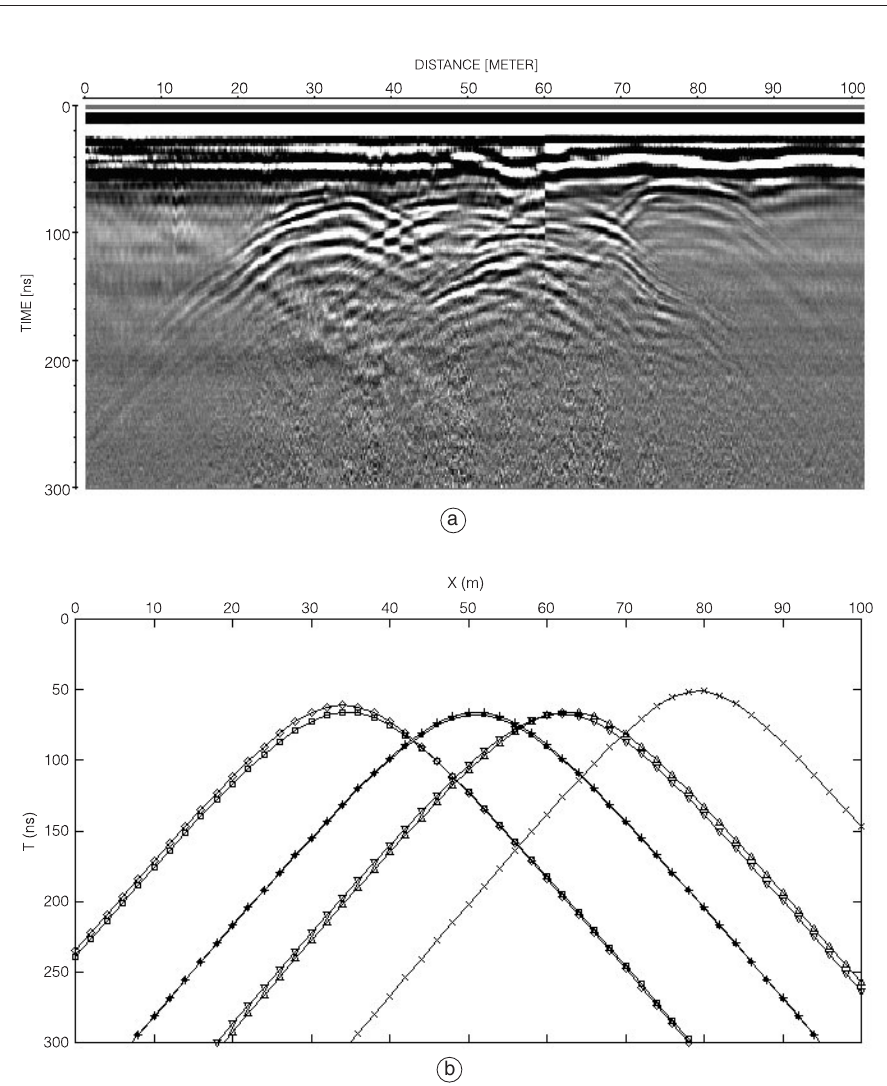
Fig. 3a,b. Example 1: Nociglia, Lecce, Italy – Surface-scattering from trees. a) Radar section relative to profile 37-38 (fig. 1); b) the corresponding kinematic